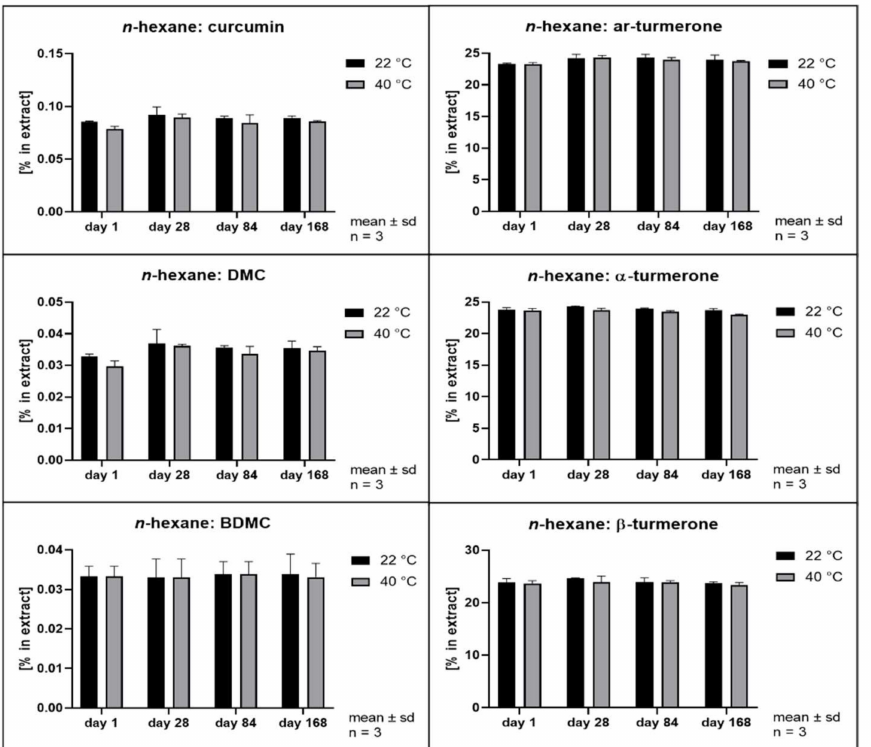
Figure 9. Contents of individual curcuminoids and turmerones in n -hexane solvent extracts through- out storage.